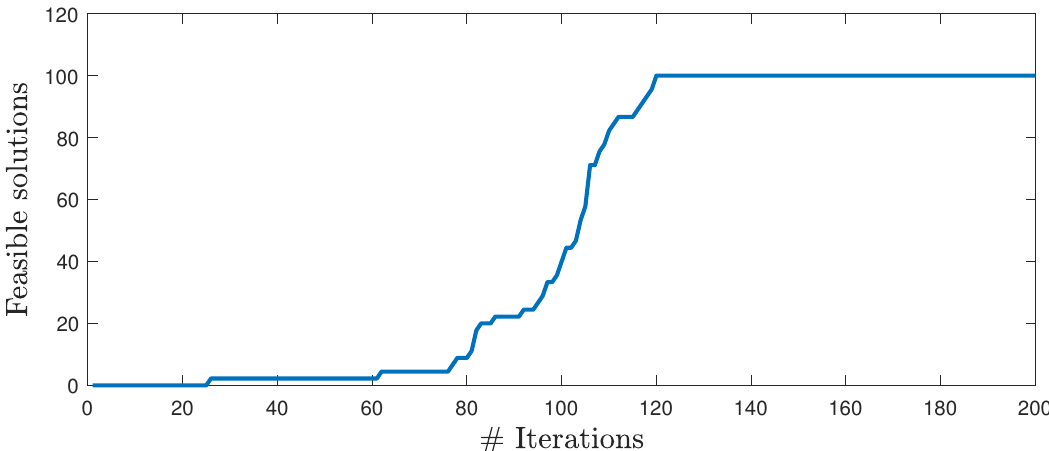
Figure 9. Computed convergence of the solving process in terms of the Grashof constraint and mass center position ( g 4 and g 7 in Table 2).